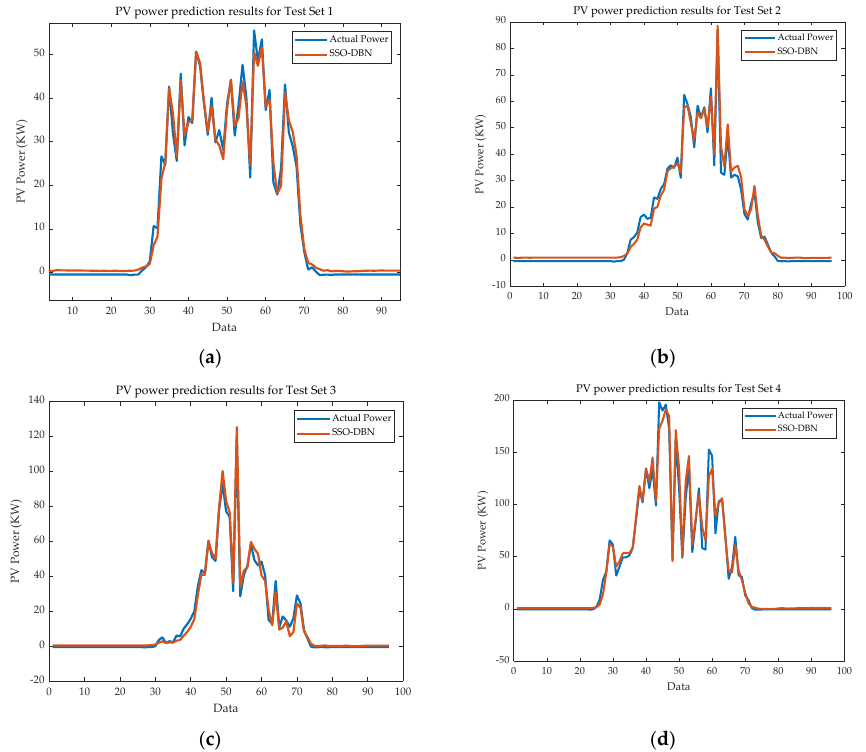
Figure 14. Prediction results of PV power under different test sets ( a − d ). Table 6. Evaluation index results under different test sets.